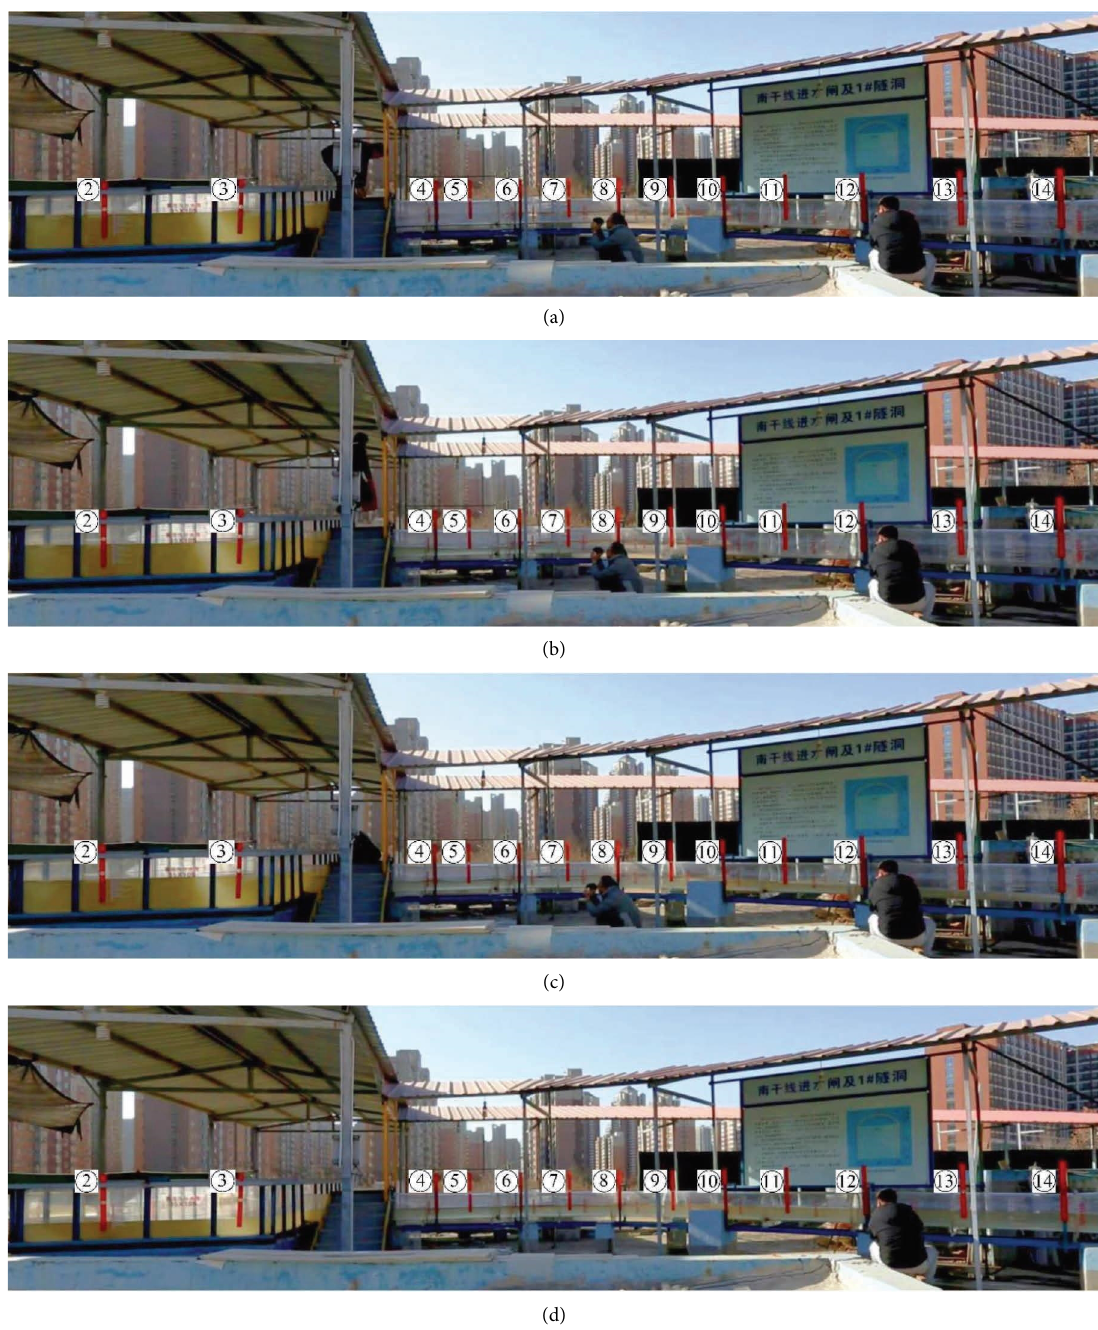
Figure 5: A panoramic view of the instantaneous water surface in the Water Distribution Pool and the Southern Main Tunnel model (a) A panoramic view at 2.0s before opening the gate. (b) A panoramic view at 1.0s after opening the gate. (c) A panoramic view at 3.0 s after opening the gate. (d) A panoramic view at 204.0s after opening the